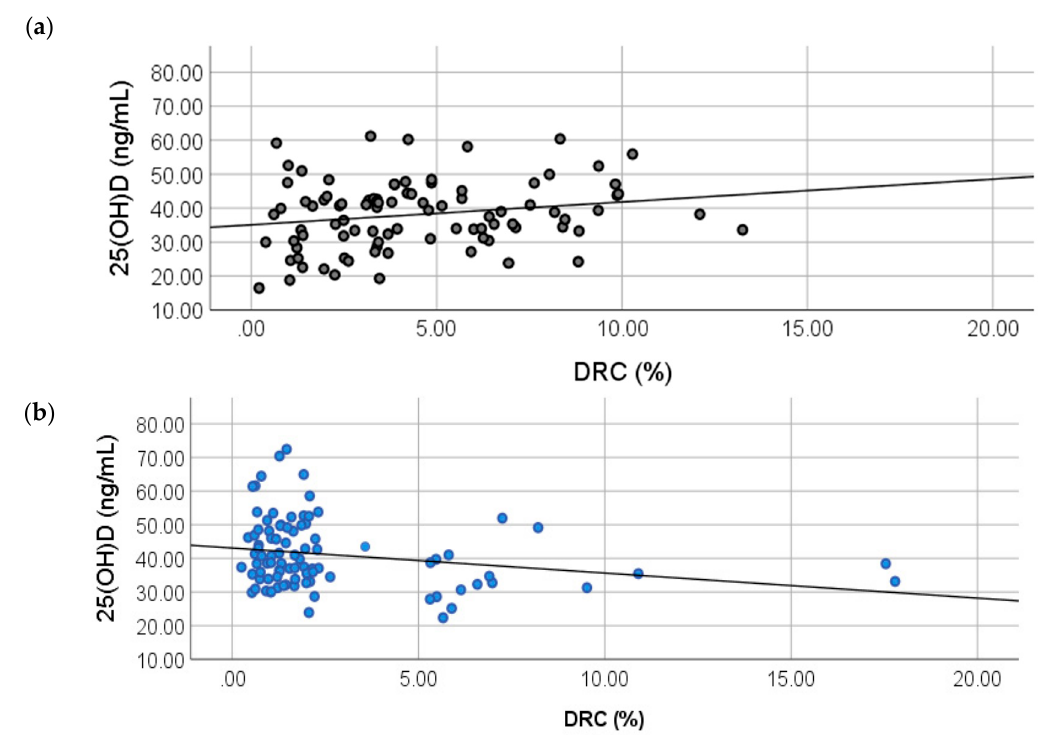
Figure 1. Correlations between DNA repair capacity (DRC) and 25(OH)D levels in breast cancer cases and controls. Partial correlation analyses were performed to test any correlations between DRC (%) and plasma vitamin D levels in ( a ) controls ( r = 0.0215, p = 0.043) and ( b ) BC cases ( r = − 0.236; p = 0.026).